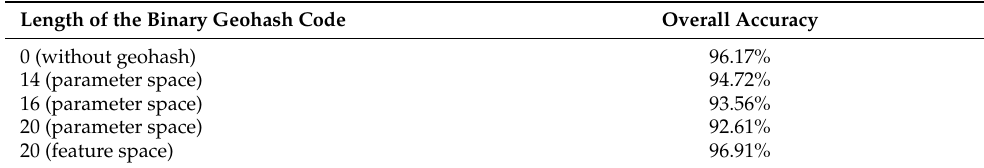
Table 2. Different lengths of the binary geohash on the GID dataset.